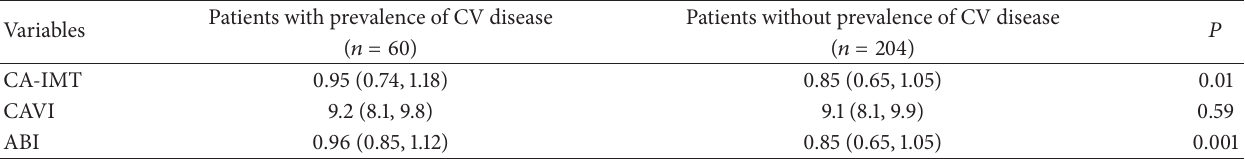
Table 3: Comparison of arteriosclerosis markers between hemodialysis patients with or without prevalence of cardiovascular disease.